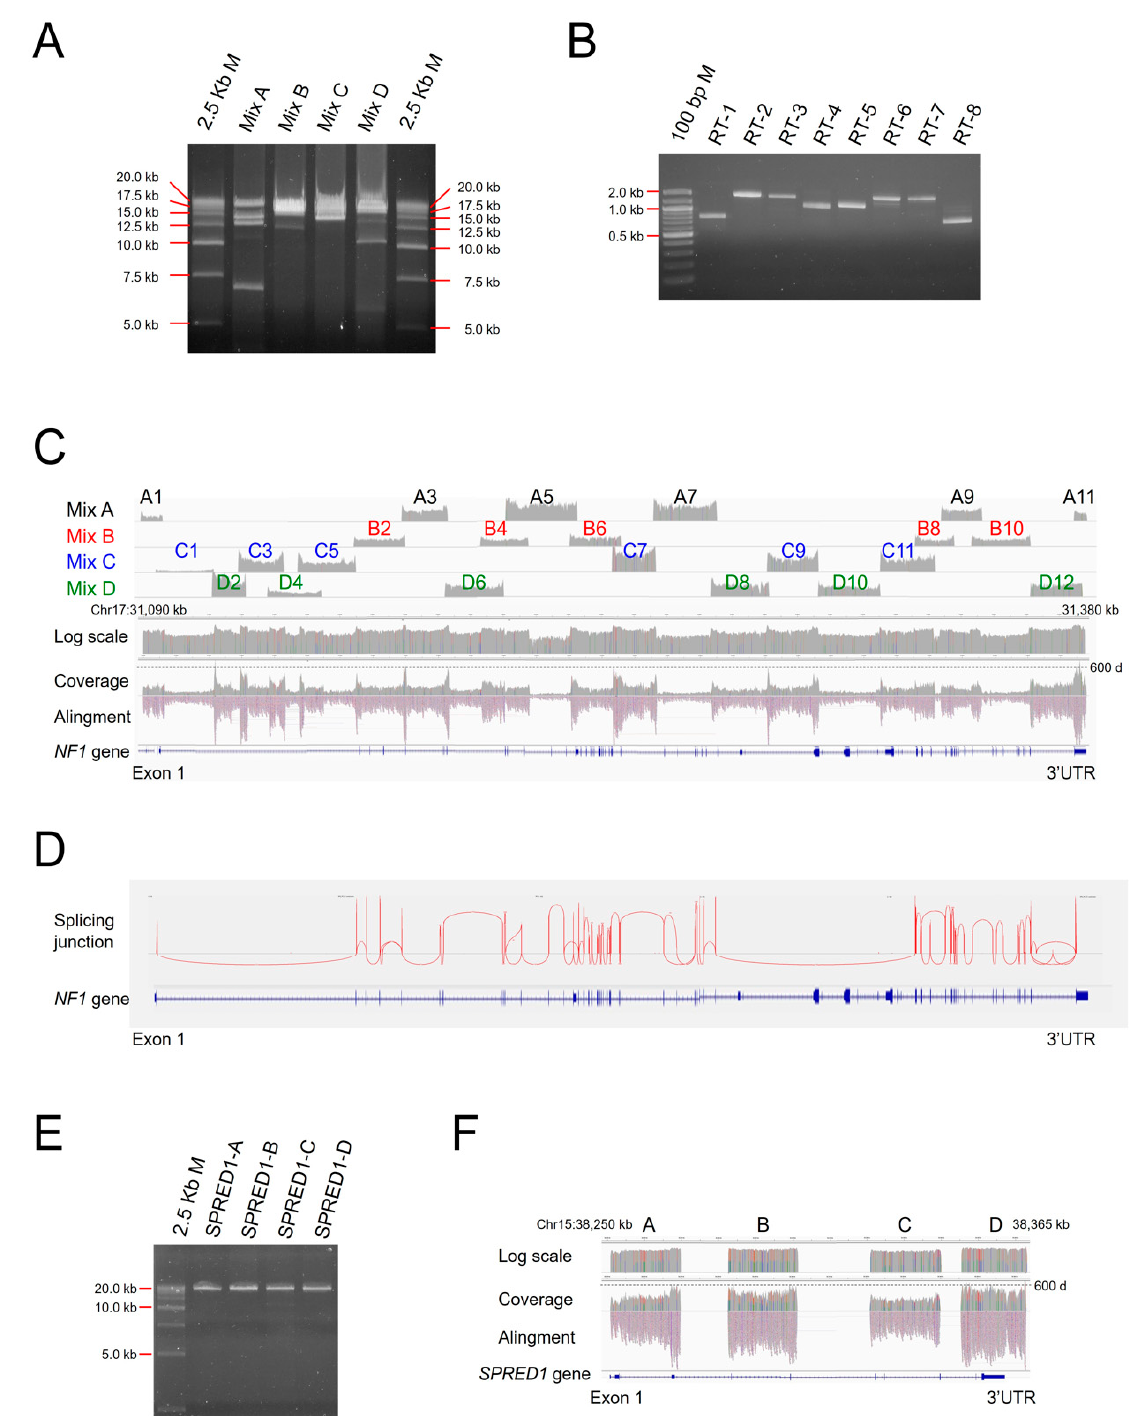
Figure 1. Combined long amplicon sequencing (CoLAS) for NF1 diagnosis. ( A ) The 0.4% agarose gel electrophoresis of NF1 multiplex long-range PCR products. ( B ) The 1.0% agarose gel electrophoresis of NF1 RT-PCR products. ( C ) Integrative Genomic Viewer (IGV) bam coverage of NF1 multiplex long amplicon sequencing (MuLAS). Library preparations were done each A–D multiplex mix amplicon (upper panel) and all pooled amplicons (lower panel). Dashed line in the coverage track indicates a 600 depth. ( D ) Sashimi plot of NF1 reverse-transcribed long amplicon sequencing (rLAS). ( E ) The 0.5% agarose gel electrophoresis of SPRED1 long-range PCR products. ( F ) IGV bam coverage of SPRED1 very long amplicon sequencing (vLAS).